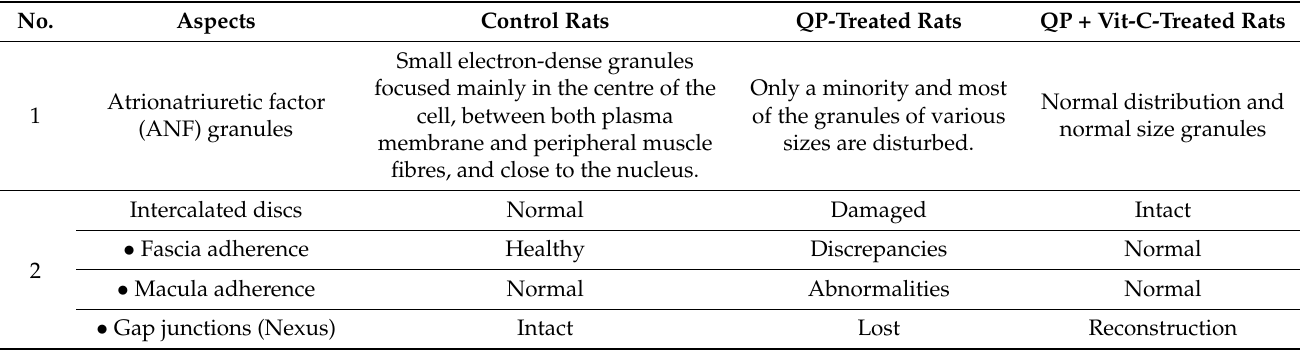
Figure 3. Light micrographs of the rat atrial muscles have been utilised from all groups (X400; H&E). ( A ). Control rat’s group displaying acidophilic sarcoplasm in cylindrical muscle fibres, a large, oval, central vesicular nucleus (N), and branching anastomosing cardiac muscle fibres. ( B ). QP-treated rat’s group exhibiting cardiac muscle fibre breakdown and discontinuance (arrow) and regions of pale acidophilic cytoplasm with pyknotic nuclei. ( C ). QP-treated rat’s group showing widened intracellular spaces (ICS) between cardiac fibres; blood vessels (BVs) are congested, with red blood cell extravasation (arrow) in the interstitium and mononuclear cellular infiltration (arrowheads). ( D ). QP + VIT-C-treated rat’s group exhibiting cardiac muscle fibres with centrally oval vesicular nuclei in a near-normal configuration. Scale bar 50 μ m. Table 1. Histological and ultrastructural parameters of control; QP-treated rats and QP + Vit-C-treated rats.